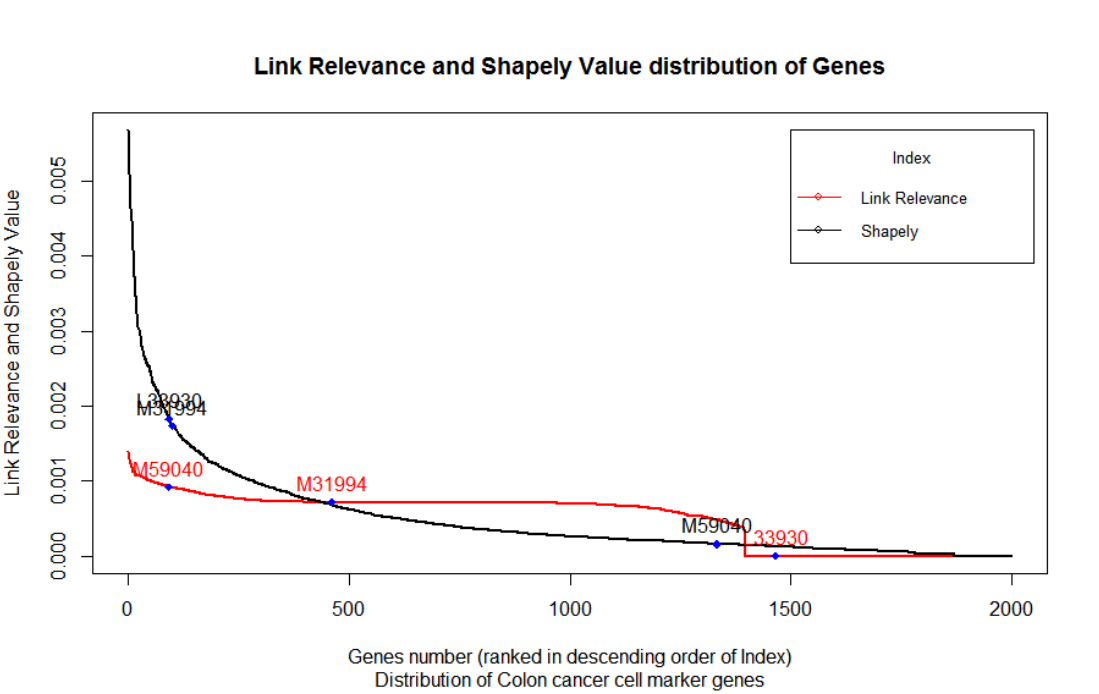
Figure 4. The LRI and Shapley Value score of gene sets arranged in a rank-wise manner and the position of the three biomarkers relative to each other. Table 2. List of well-validated biomarkers for colon cancer stem cells from the validated experimental setup (along with a review for more reference and importance) retrieved from the CellMarker database [39] and populated thereafter (for the ease of